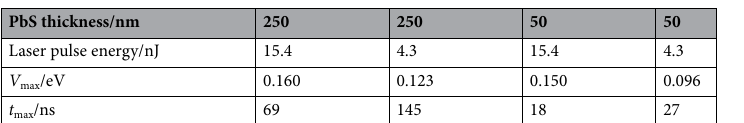
PbS thickness/nm